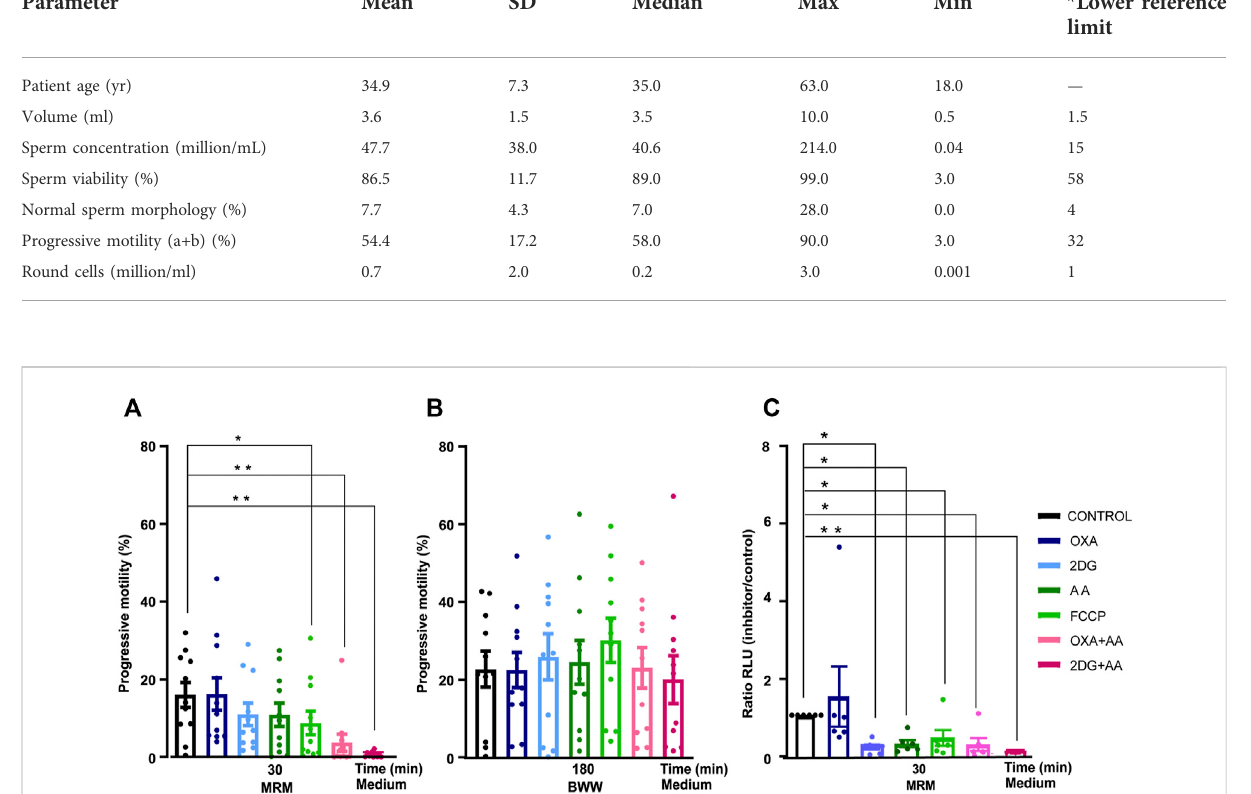
TABLE 1Descriptive characteristics of participants ’ sperm parameters. Data were obtained by analyzing the fi rst spermiogramof 339 individuals who attended the andrology clinic. Max = maximum value. Min = minimum value *lower reference values (WHO, 2010). Parameter